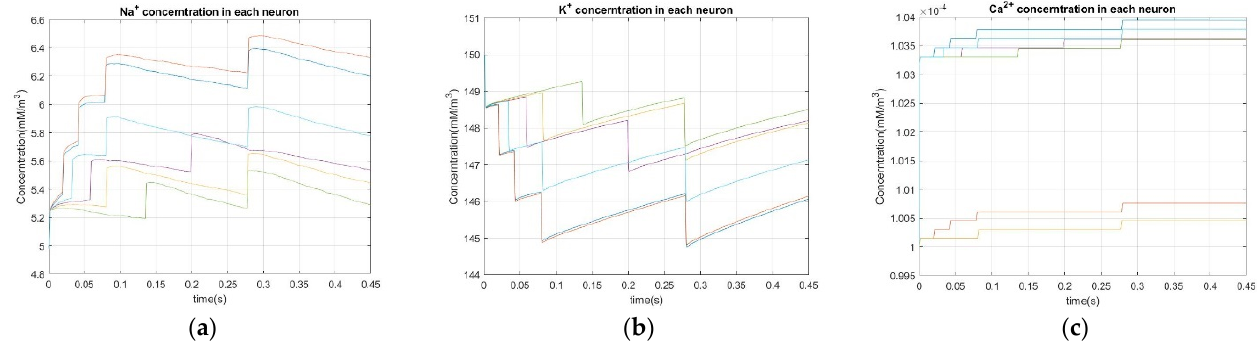
Figure 2. Ion concentration in each neuron ( a . Na + concentration in each neuron; b . K + concentration in each neuron; c . Ca + concentration in each neuron).